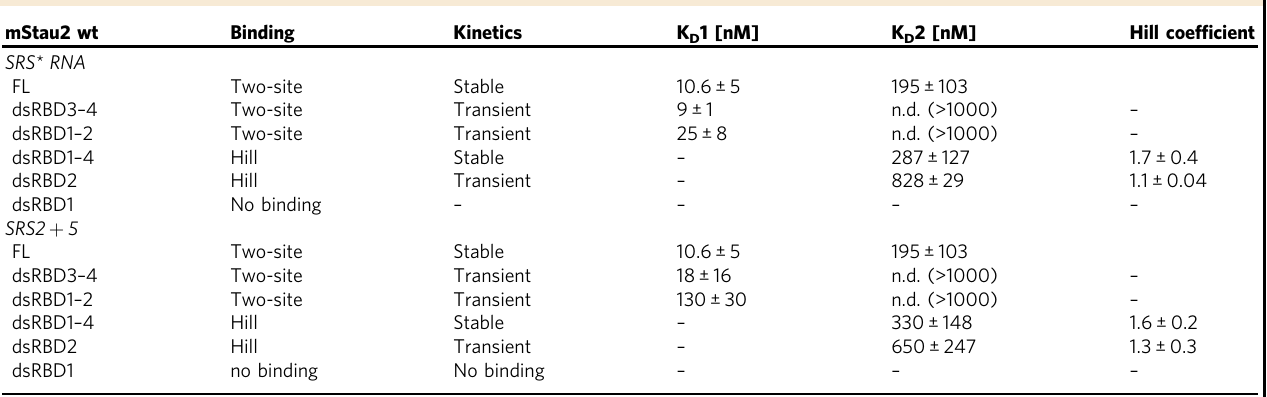
Table 2 mStau2 binding to SRS* and SRS2 + 5 RNA mStau2